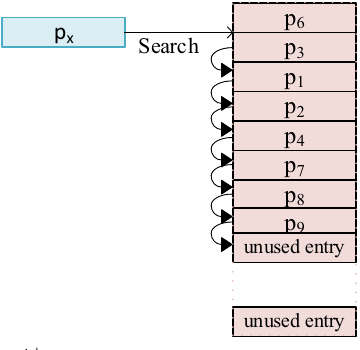
Fig. 2 Adding rule in the first